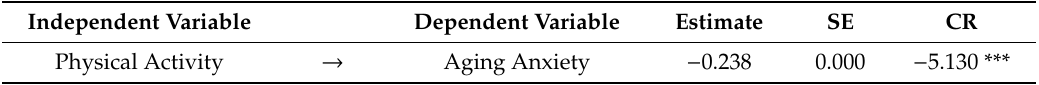
Table 7. Path coe ffi cient of full-e ff ects